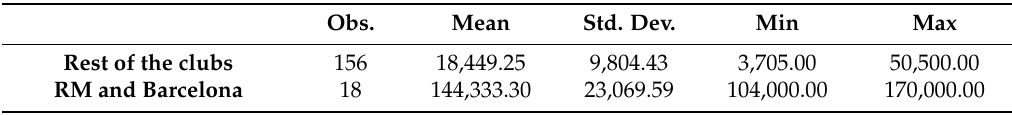
Table 1. Descriptive statistics for Real Madrid (RM) and Barcelona audit fees and those of the rest of the clubs. (Data in Euros corrected for inflation).